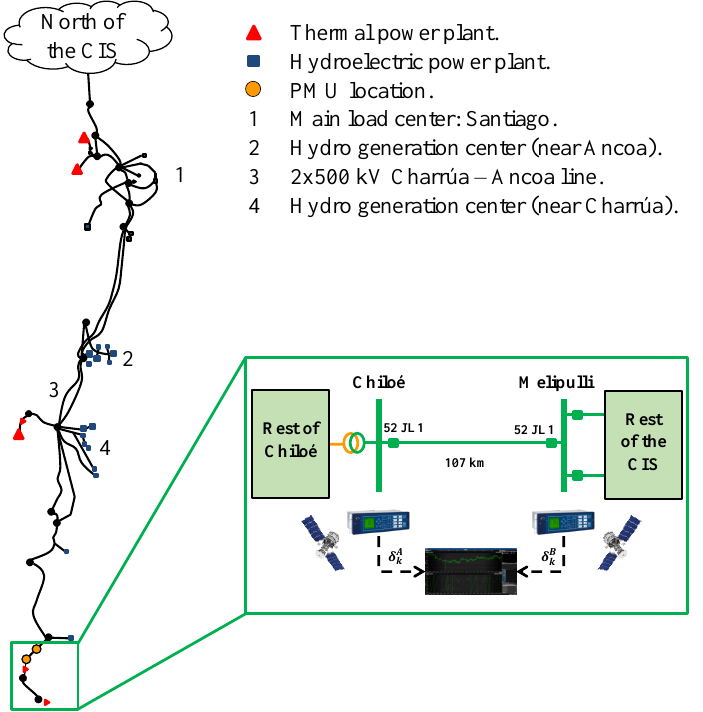
Figure 10. Simplified diagram of the Central Interconnected System (CIS) of Chile.